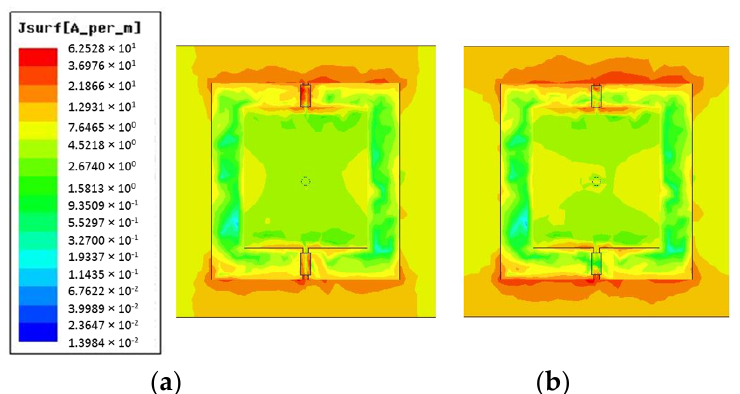
Figure 5. The surface current distribution analysis of the unit cell in ( a ) ON state ( b ) OFF state.